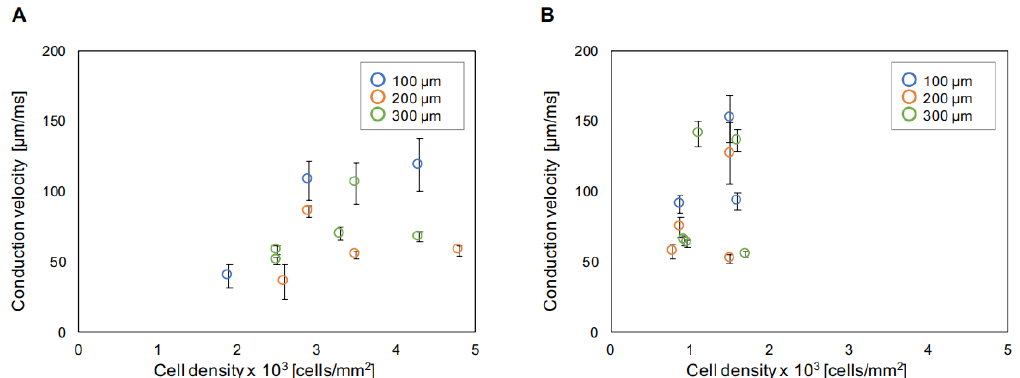
Figure 4. Cell concentration dependence of conduction velocity in unit lengths. Mean conduction velocities of mouse primary cells ( A ) and hES cells ( B ) in 300 µ m unit length were plotted. Blue circles for 100 µ m width, orange circles for 200 µ m width, and green circles for 300 µ m width, respectively. Error bars are S.D. of the mean conduction velocities.